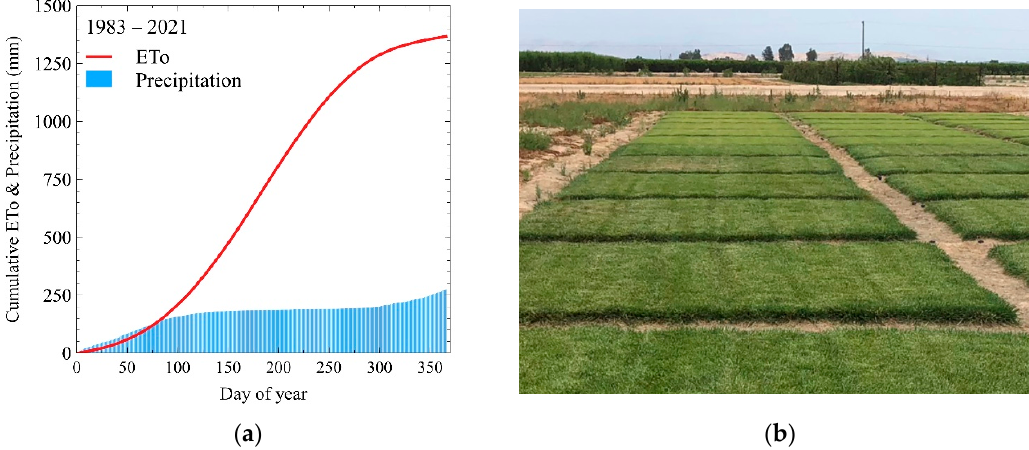
Figure 2. The long-term mean reference evapotranspiration (ET o ) and precipitation trends at the study site from a nearby weather station ( a ). A photo taken on 30 May 2018 showing the research plots ( b ).